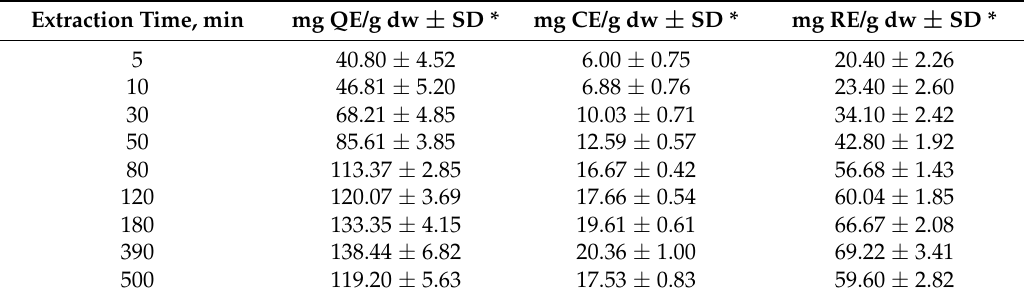
Table 2. Total flavonoid content expressed as quercetin, rutin and (+)-catechin equivalents in mg per g dry weight of the Cistus incanus leaf, stalk, and bud